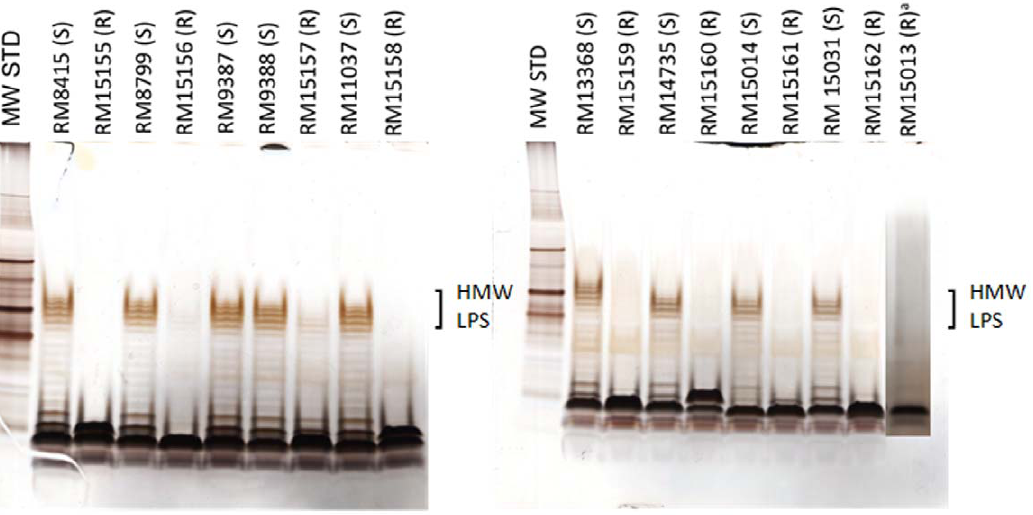
Figure 2. Silver stained SDS-PAGE analysis of LPS extracted from E.coli O104 strains and resistant mutants. See Tables 1 and 2 for strain details. The pyocin-resistant strains (R) express a highly truncated O-antigen, or O-antigen that have a decreased concentration of the high molecular weight structure (HMW LPS) compared to the pyocin-sensitive strains (S). a Strain RM15013 was run in a different gel than the other strains shown in this